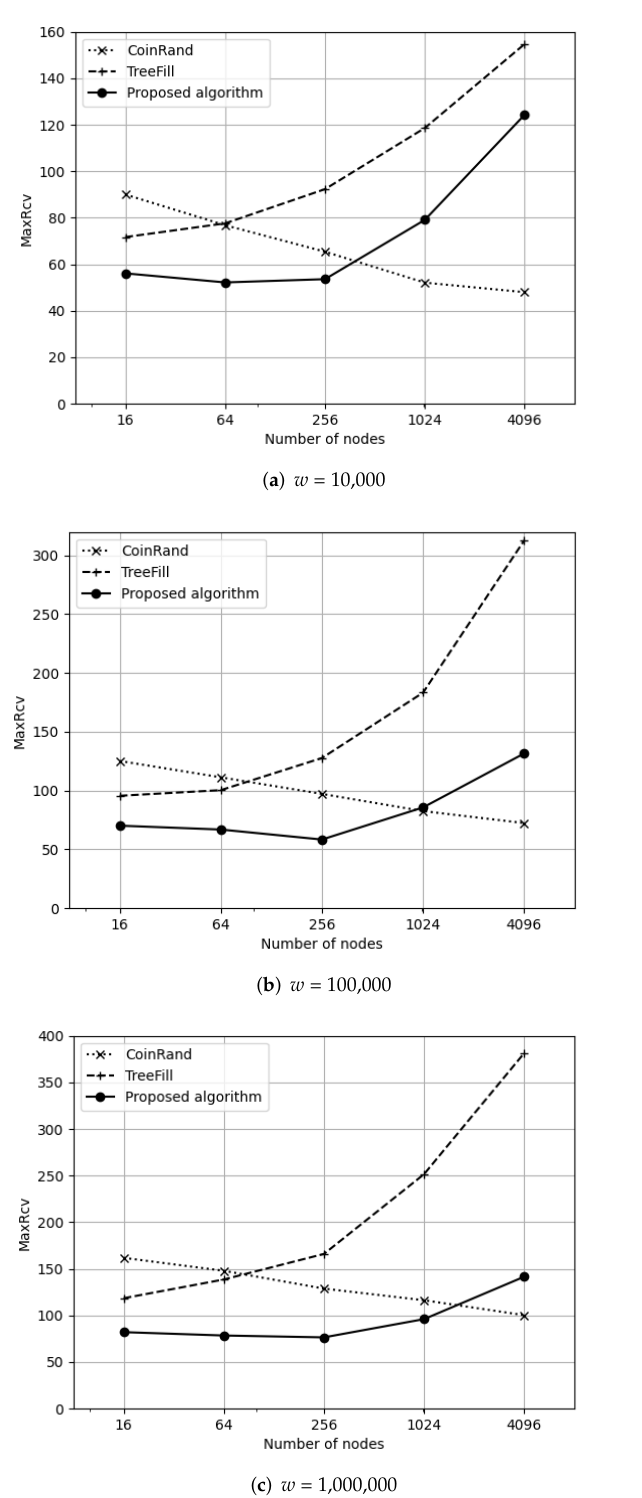
Figure 3. Comparison of MaxRcv between CoinRand , TreeFill , and the proposed algorithm when the number of nodes is 16, 64, 256, 1024, and